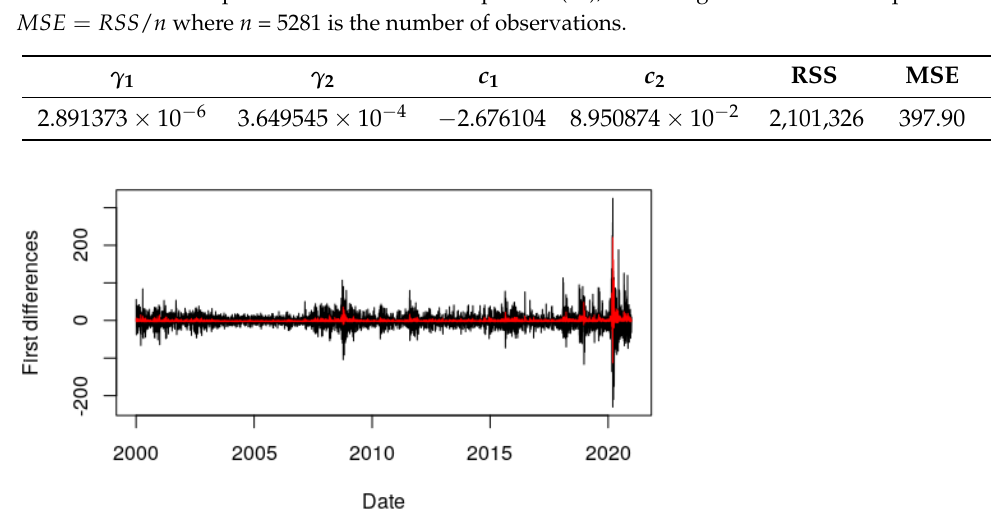
Figure 7. First differences in black, approximation in red. Implementation using pattern